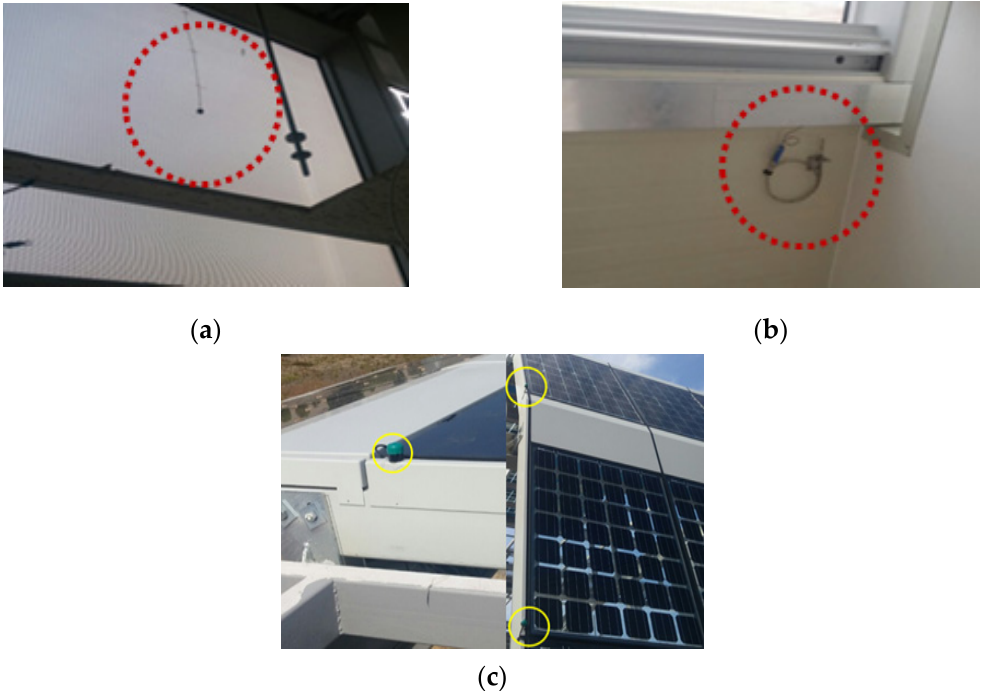
Figure 4. Installation of the measurement sensors: ( a ) Module temperature sensors; ( b ) Indoor temperature sensors; ( c ) Irradiation sensors for detecting installation direction and angle.